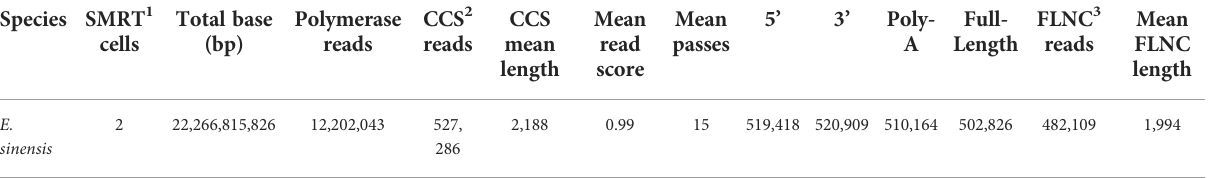
TABLE 2 PacBio Iso-seq output statistics in E. sinensis